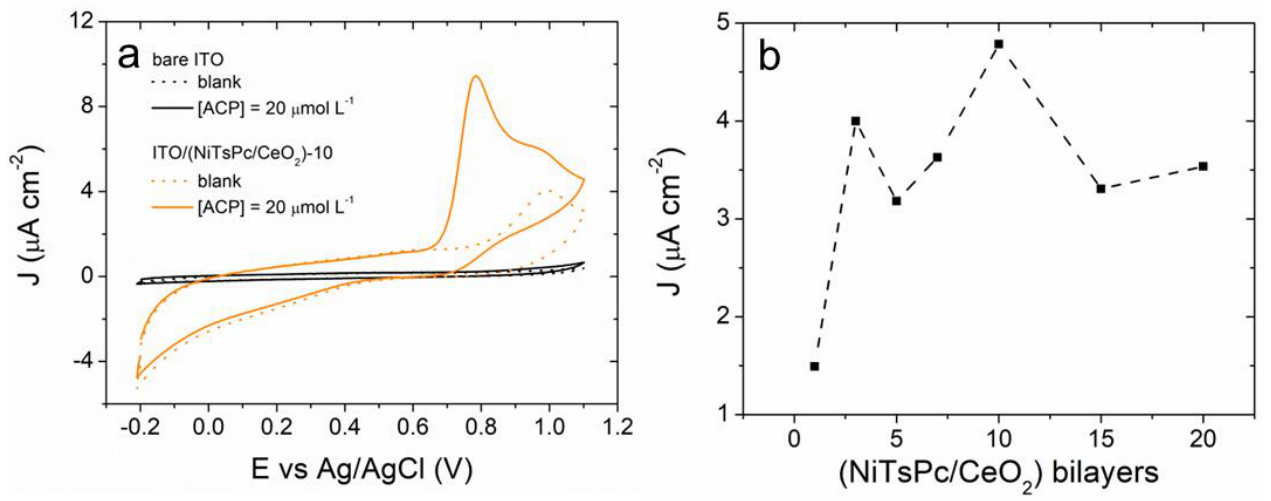
Figure 2. ( a ) Cyclic voltammograms registered in plain electrolyte (0.1 M sodium acetate, pH 3) and in ACP solution (20 µM) using bare ITO and ITO/(NiTsPc/CeO 2 )-10. Scan rate: 25 mV s −1 . ( b ) De- pendence of ACP oxidation current density on the number of (NiTsPc/CeO 2 )